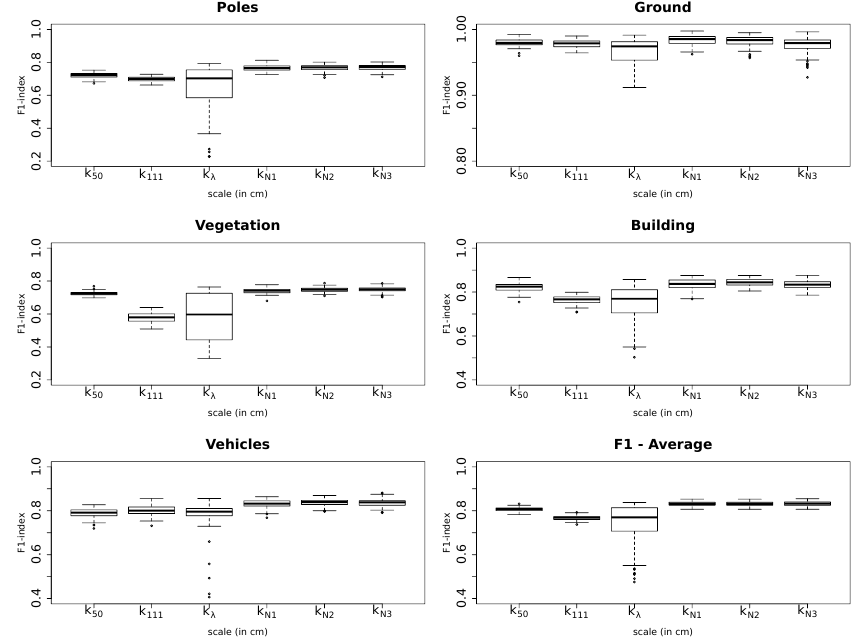
Figure 11. F1 index for each class and average F1 for all the classes (bottom